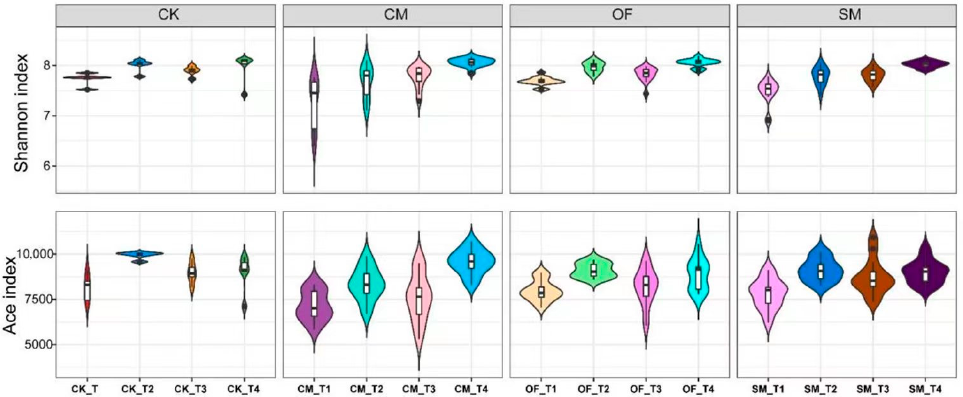
Figure 2. The Shannon and Ace indices of microbial community with different fertilizers (CK: control; CM: chicken manure; OF: organic fertilizer; SM: swine manure).